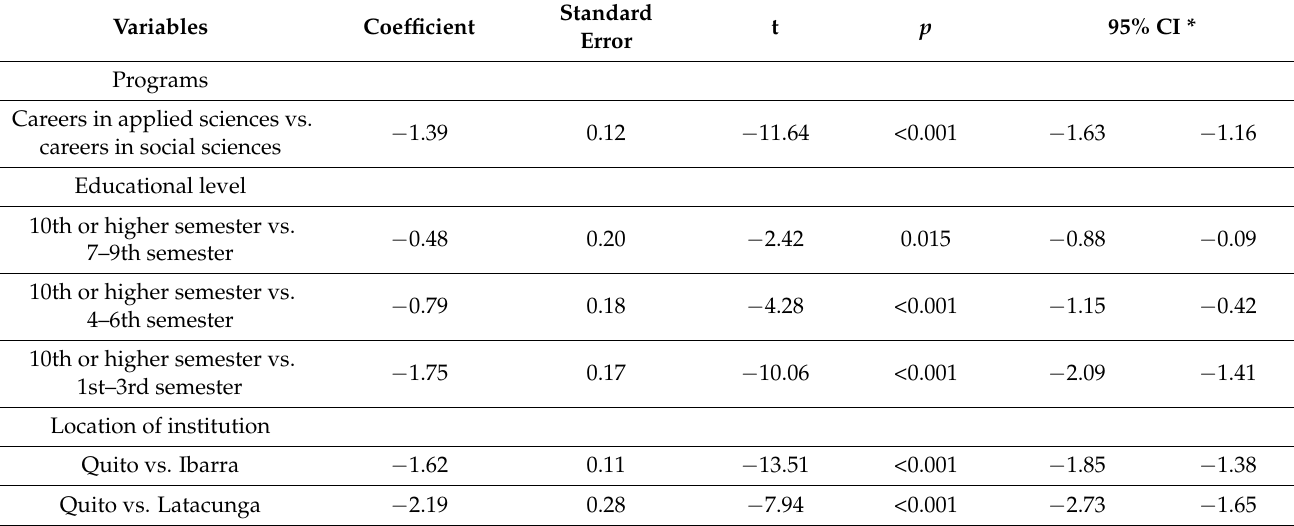
Table 3. Results of the multiple linear regression on factors related to low scores regarding COVID-19 knowledge.